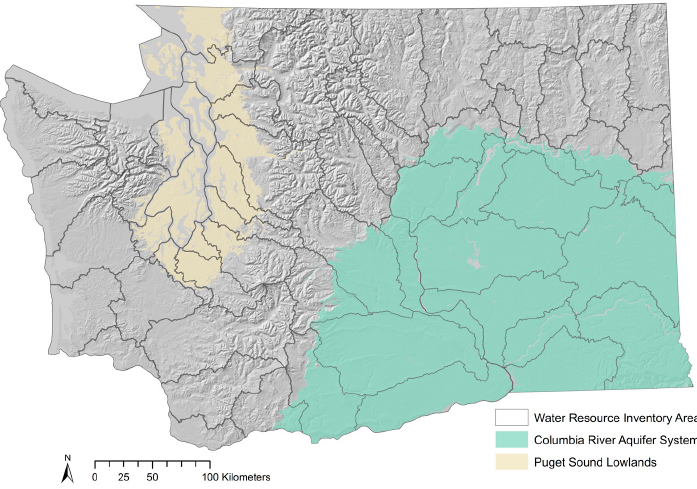
Figure 2. Washington State Water Resource Inventory areas and the state’s principal aquifers.